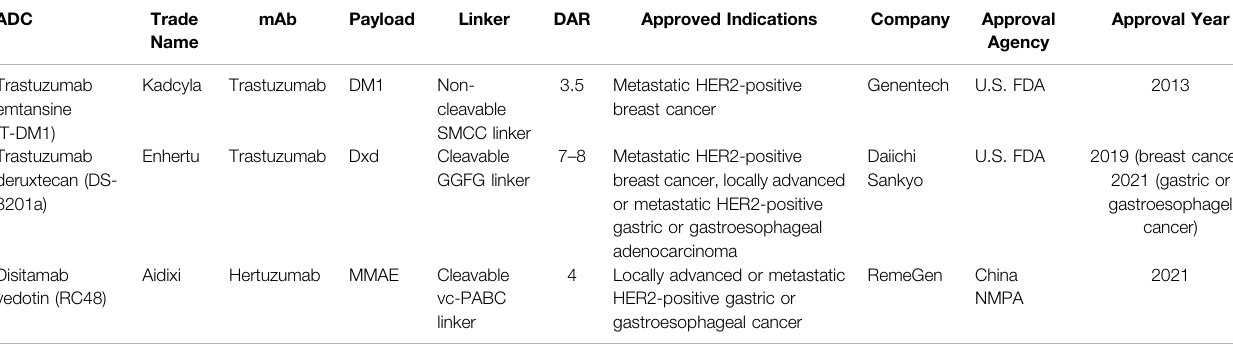
TABLE 2 | Currently approved anti-HER2 ADCs on the market.